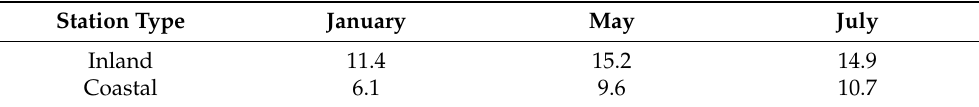
Table 2. Average diurnal temperature range ( ◦ C) for two inland and two coastal sites for winter, spring and summer.